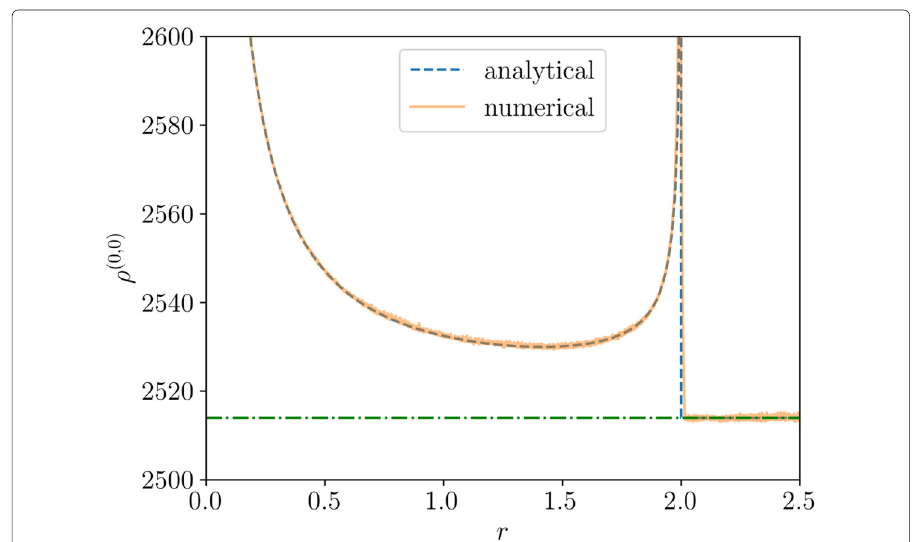
Fig. 11 Numerical and analytical solution for the scalar pair density ρ ( 0,0 ) as a function of r in a distributions of loops with radius R = 1. The dash-dotted green line corresponds to the background pair density − 1 )/ V = ρ 2 π R ( N l